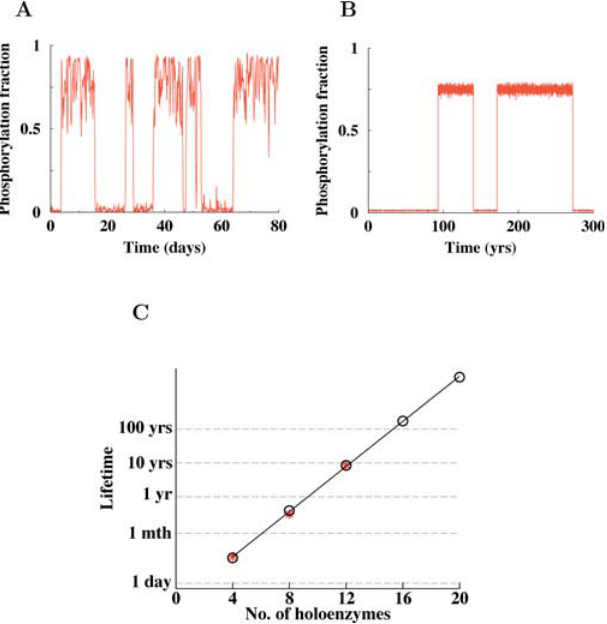
Figure 3. Stability of the Switch Increases Exponentially with System Size (Number of CaMKII Holoenzymes and PP1 Molecules) (A)SpontaneoustransitionsinasystemwithfourCaMKIIholoenzymes and four PP1 enzymes. Phosphorylation fraction is Sp tot /12 N CaMK . (B) System with 16 holoenzymes and 16 PP1 enzymes, with four times the volume of (A). Note different timescales between (A) and (B). Phosphorylation fraction is Sp tot /12 N CaMK . (C) The switch’s lifetime increases exponentially with system size. Numbers of all species scale together with system volume. Circles are data points, line is a linear fit, indicating an exponential dependence, because the ordinate is in logarithmic scale. The red asterisks indicate data points where we included the PP1–I1P fluctuations explicitly. DOI: 10.1371/journal.pbio.0030107.g003